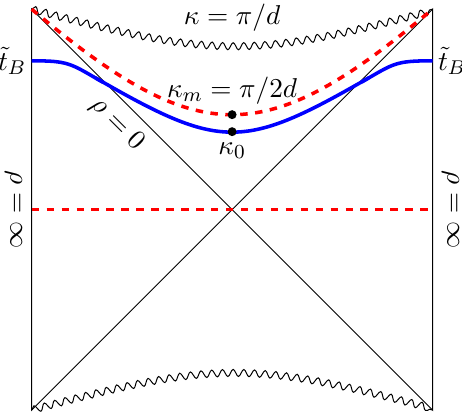
Figure 4 . Extremal surfaces in the AdS black hole. For given time slices at the left and right boundary, the volume of extremal surface connecting these two time slices (blue curve) gives the holographic complexity potential. The upper red dotted line is for ~ t B = 1 and the middle red dotted line is for ~ t B =